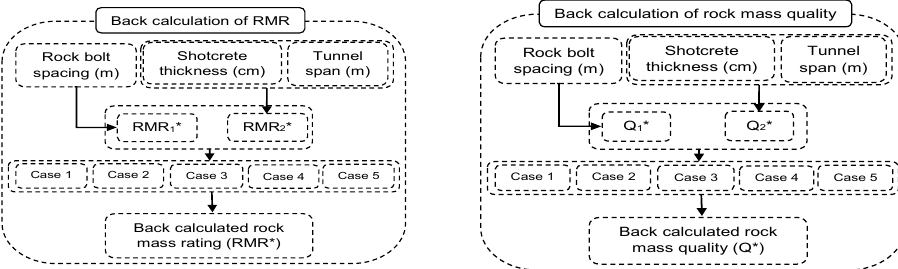
Figure 1. Back-calculation of rock-mass quality ( RMR * and Q *) based on five different cases, while considering the weightage of the rock-mass quality obtained from the rock bolts spacing and shotcrete thickness along with the tunnel span.